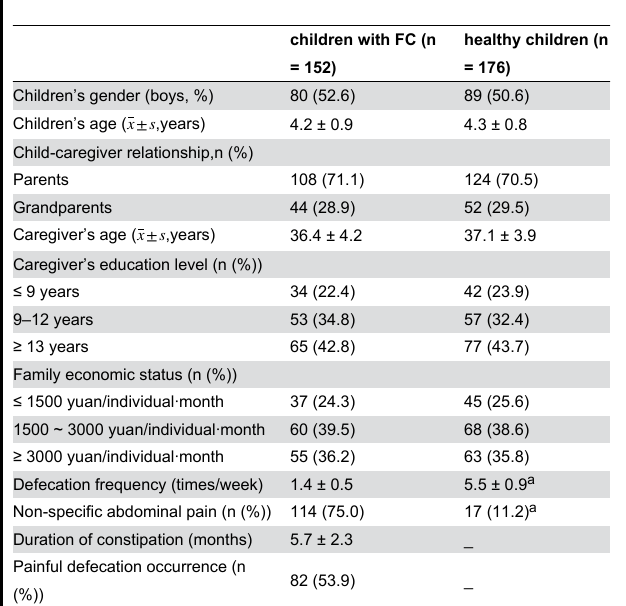
Table 2. Internal consistency (Cronbach’s α Coefficient) and item-summary correlations of PedsQL TM 4.0 Generic Core Scale and FIM Scale.